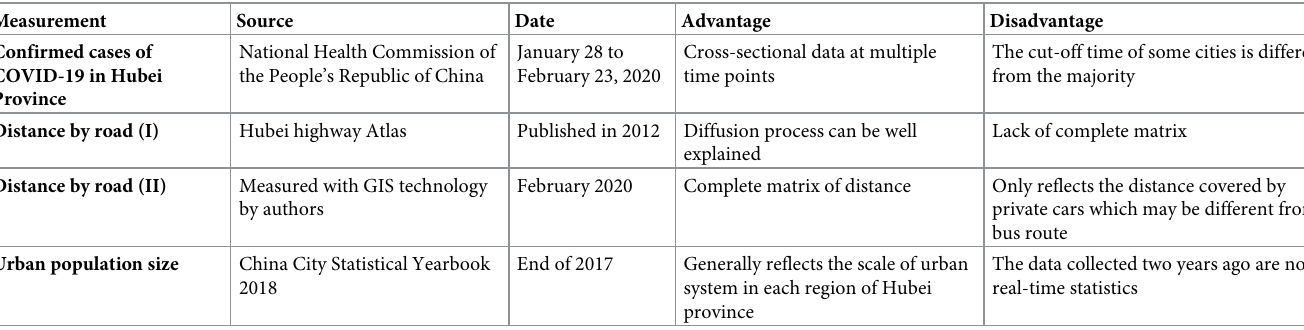
Table 1. Main data sources used in this study and related